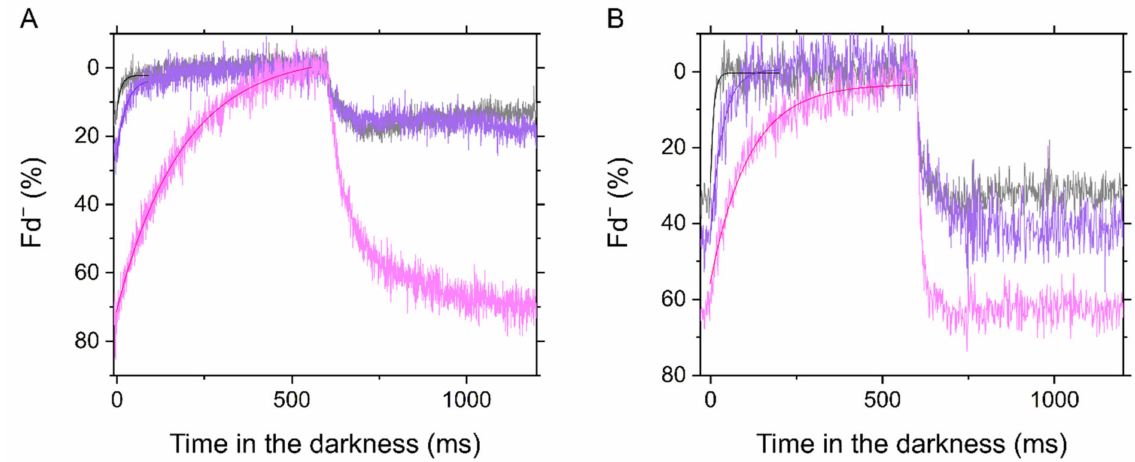
Figure 6. Dark-interval relaxation kinetics of ferredoxin (Fd − ) in the C 3 plant mustard ( A ) and the C 4 plant maize ( B ) under ambient air (40 Pa CO 2 , 21 kPa O 2 ; black), low CO 2 (1 Pa CO 2 , 21 kPa O 2 ; purple), and low CO 2 /O 2 (1 Pa CO 2 , 1 kPa O 2 ; pink). Red actinic light (550 µ mol photons m − 2 s − 1 ) was turned off at 0 ms for 600 ms during the steady-state photosynthesis. The kinetics were fit to mono exponential decay ( R 2 , coefficient of determination: 0.6628, 0.8816, and 0.9788 in A; 0.6612, 0.8307, and 0.9339 in